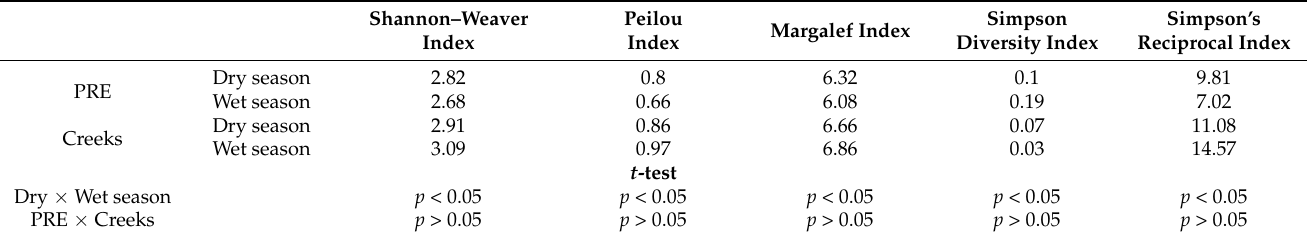
Table 5. The temporal and spatial variation of phytoplankton alpha diversity